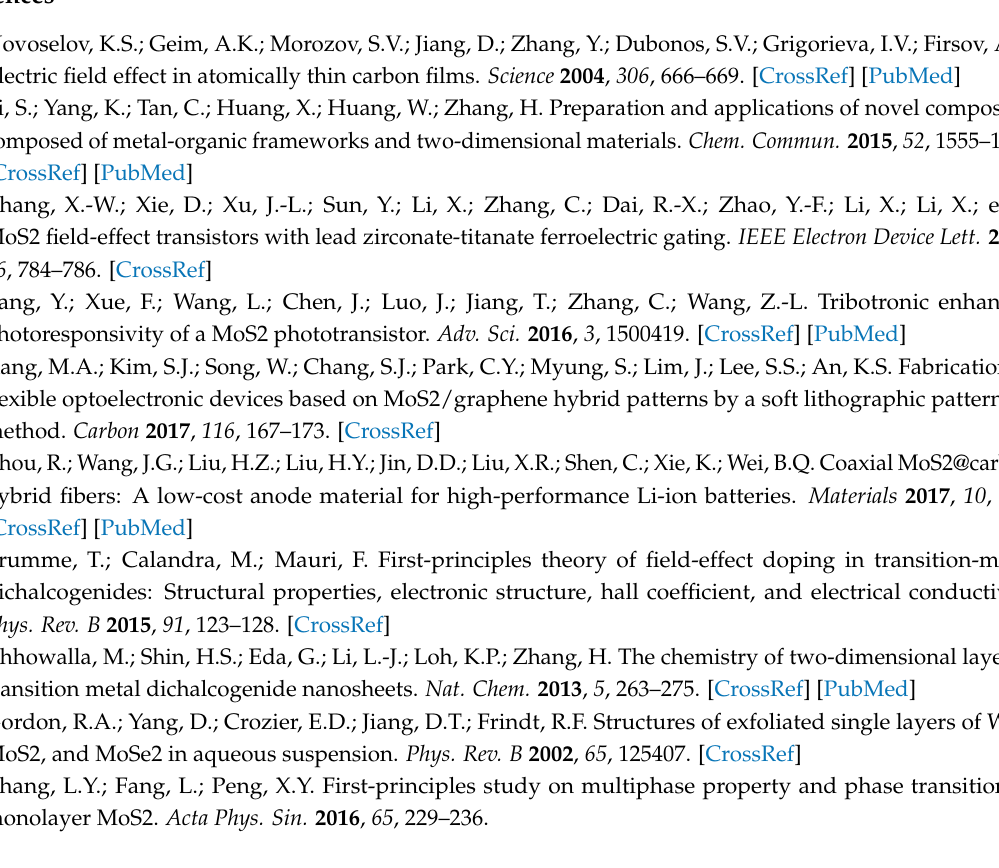
Figure S1: The Mo-S and S-Mo bond lengths ( a , d and h ), S-Mo-S bond angles and Mo-S-Mo angles ( b , e and i ), and layer thickness of S-S ( c , f and j ) versus deflection during the loading process and unloading process with indenter radii of 15 Å, 20 Å and 40 Å (The labeled atoms are shown in Figure